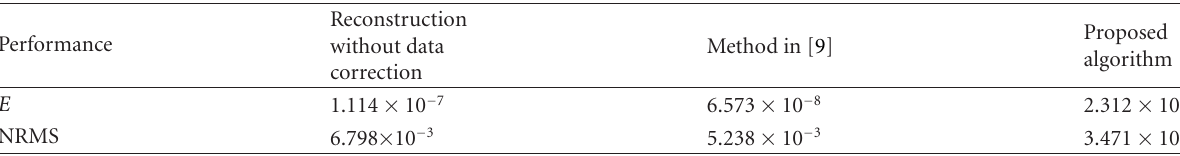
Table 2: Performance comparison of reconstruction algorithms.